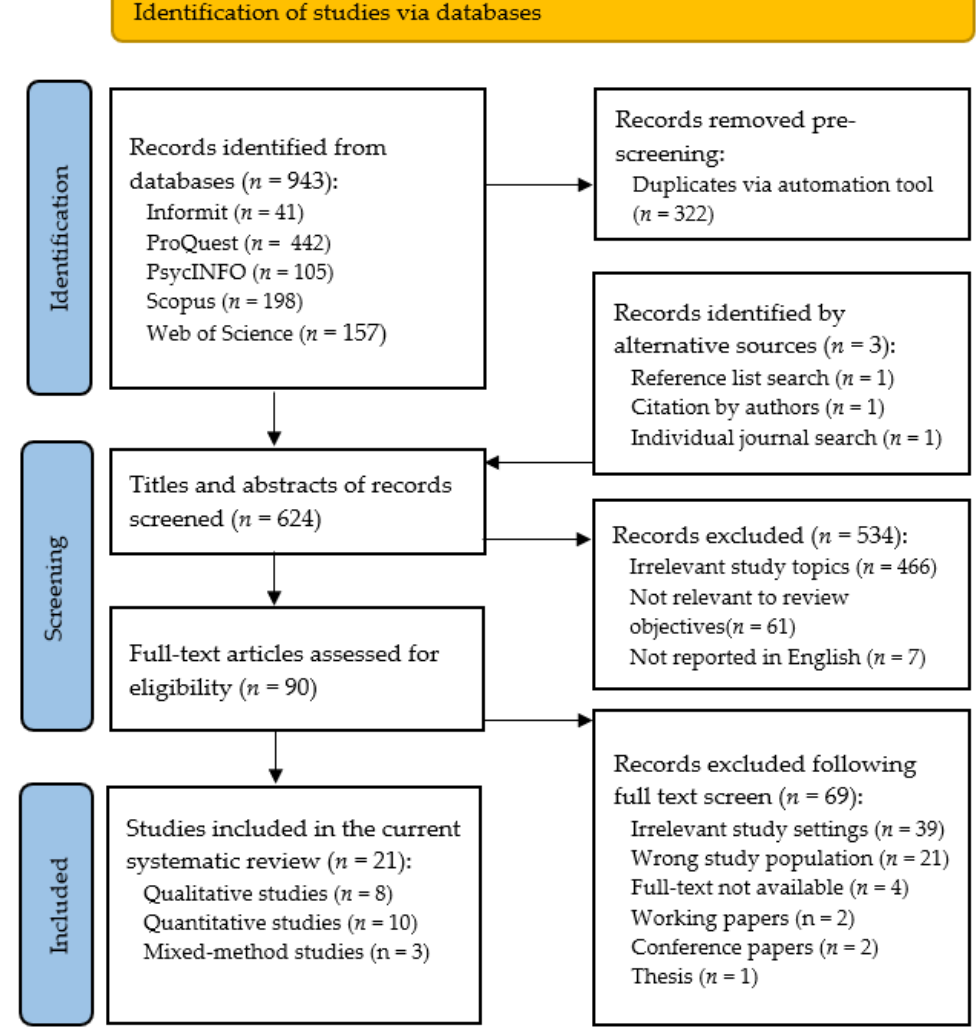
Figure 1. PRISMA Flow Diagram of Studies included.